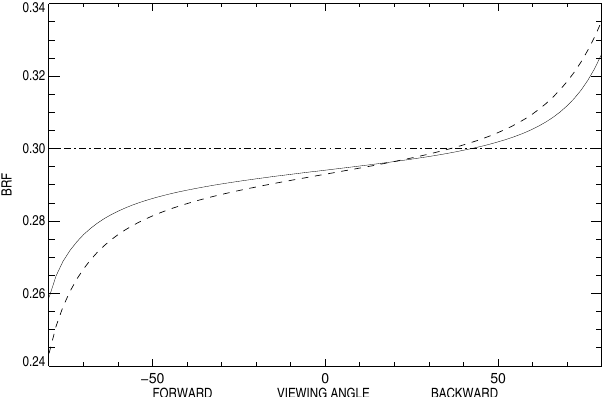
Figure 8. Raytran surface BRF simulation in the principal plane over the 20 × 20 km ROI for SZA = 50 ◦ . The solid line corresponds to SAA of 135 ◦ and the dashed line to SAA = 225 ◦ . The dashed-dotted line shows the sand reflectance level used for the elementary triangles composing the Libya-4 site topography within